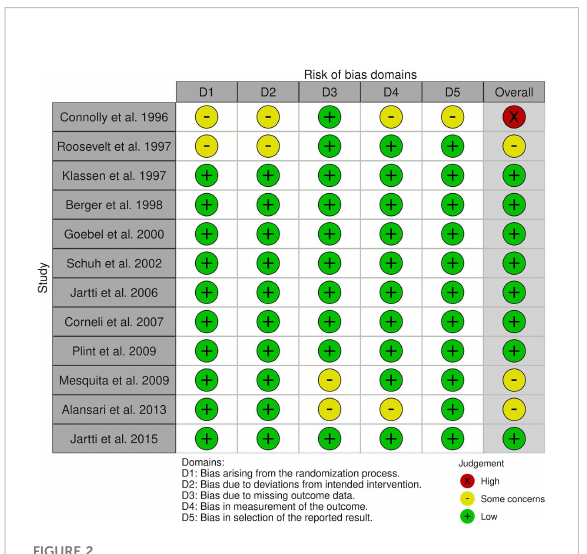
FIGURE 2 Summary of risk of bias assessment of the eligible